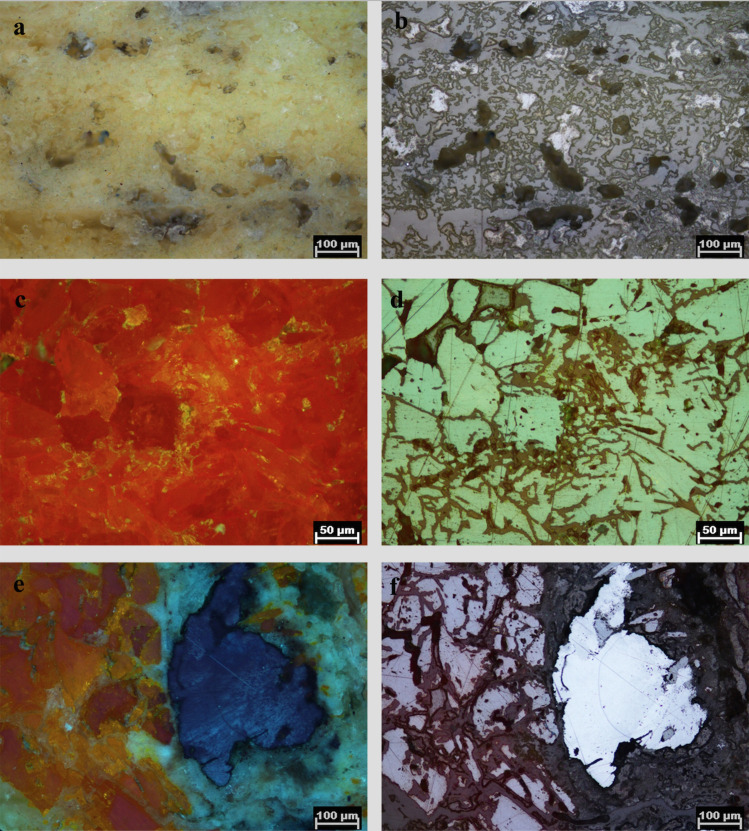
Thin section petrography of the ore fragment.a) orpiment, single Nicol; b) orpiment, crossed-Nicols; c) realgar, single Nicol; d) realgar, crossed-Nicols; e) orpiment–realgar with stibnite, single Nicol; f) orpiment–realgar with stibnite, crossed-Nicols.